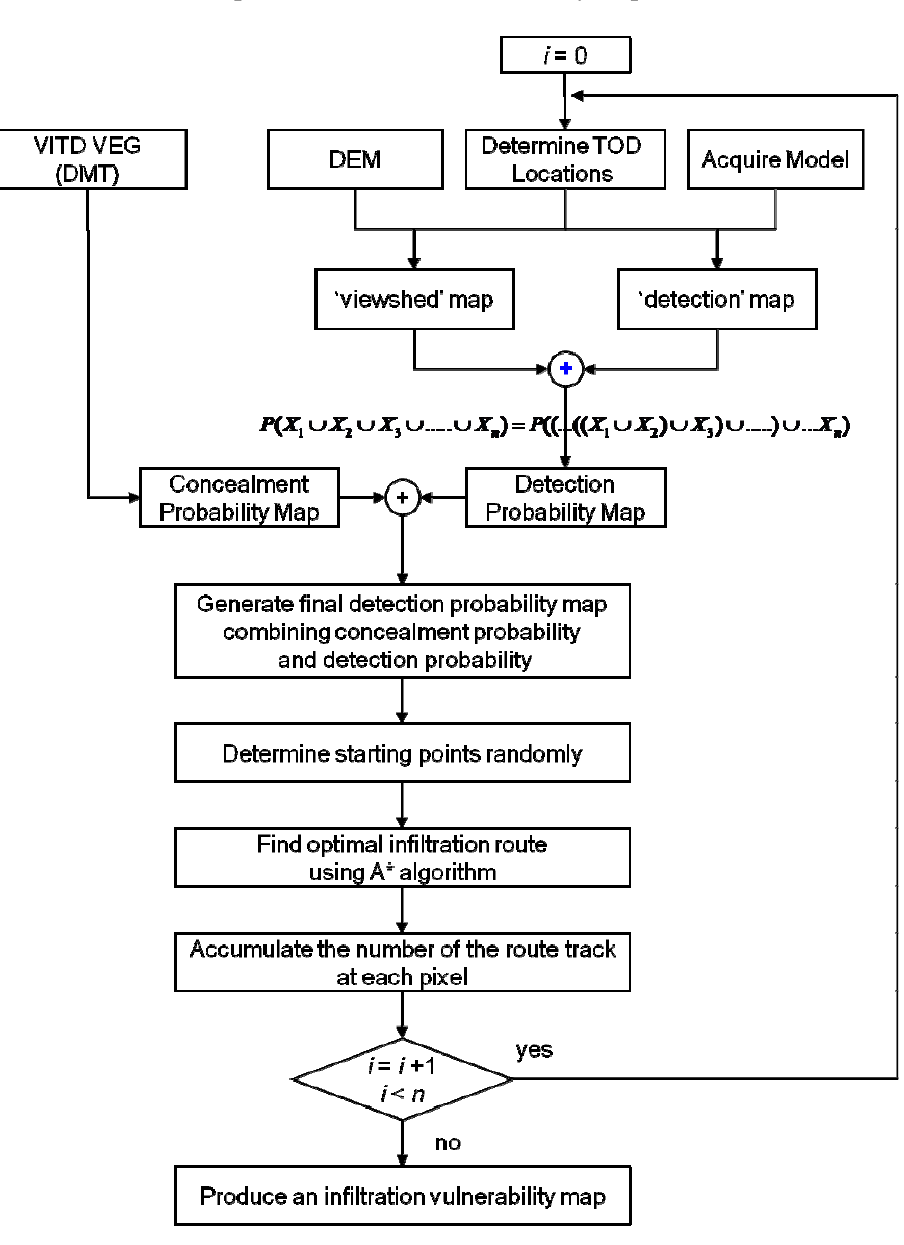
Figure 3. Optimal infiltration-route analysis